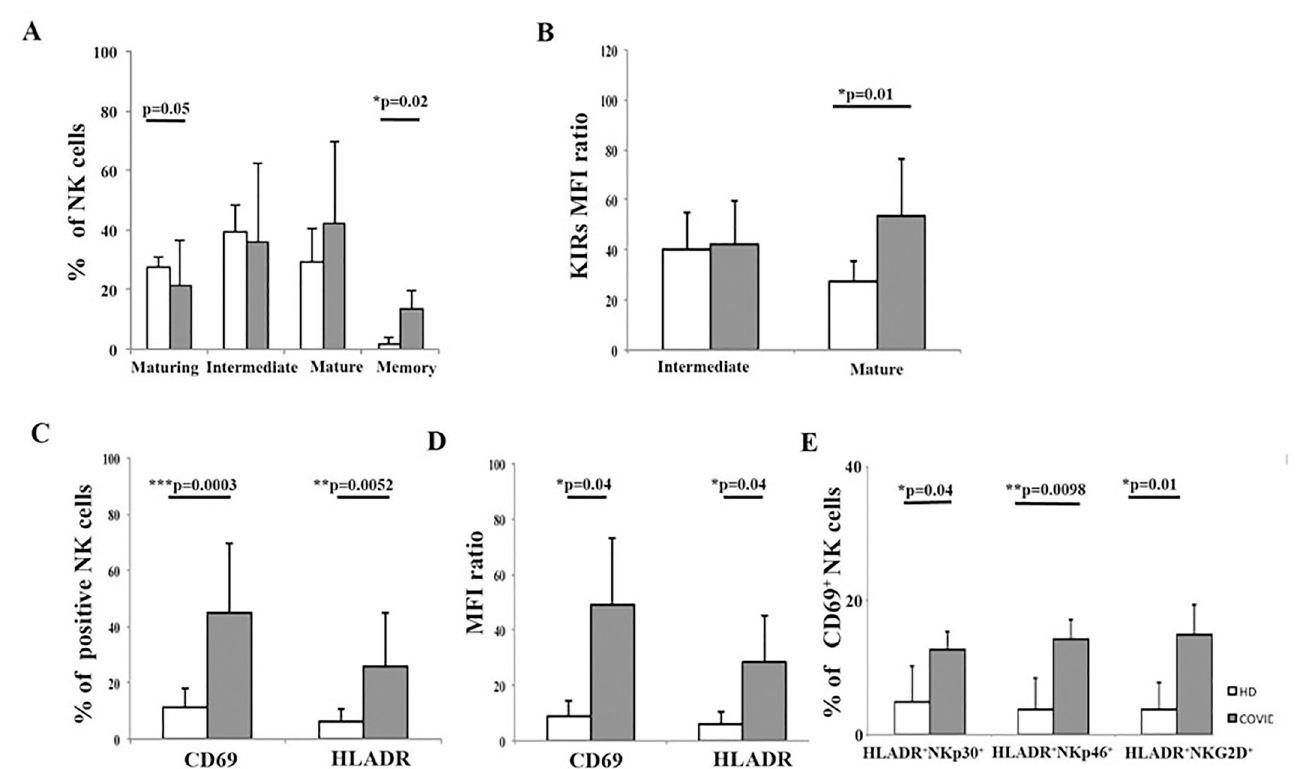
Fig 2. Flow cytometric analysis of peripheral blood NK cell development and activation in COVID-19 patients. Analysis is performed on CD3-CD14-CD19- cells by flow cytometry in COVID-19 patients (#28) and HD (#18). Histograms show mean ± SD. Significance by Mann-Whitney U-test analysis is indicated. Open histograms: HD. Greyed histogram: COVID-19. Panel A: Analysis of circulating NK cell development according to NKG2A and KIR expression of PB cells. KIR and NKG2A were analyzed on CD3-CD14-CD19-CD56+CD16+ cells. Maturing = KIR-NKG2A+. Intermediate = KIR+NKG2A+. Mature = KIR+NKG2A-. Memory = CD85j+KIR+ CD57+NKG2A-. Panel B: MFI ratios of KIR expression in NK cells. MFIr = mean fluorescence intensity ratio calculated as (MFI sample–MFI neg control)/MFI neg control. MFIr expresses NK cell molecule density. Panel C: Proportions of NK cells expressing CD69 and HLA-DR. Panel D: MFI ratios of CD69 and HLA-DR on PB NK cells. MFIr = mean fluorescence intensity ratio calculated as (MFI sample–MFI neg control)/MFI neg control. MFIr expresses NK cell molecule density. Panel E: analysis of the expression of HLA-DR in NKp46+, NKp30+, or NKG2D + NK